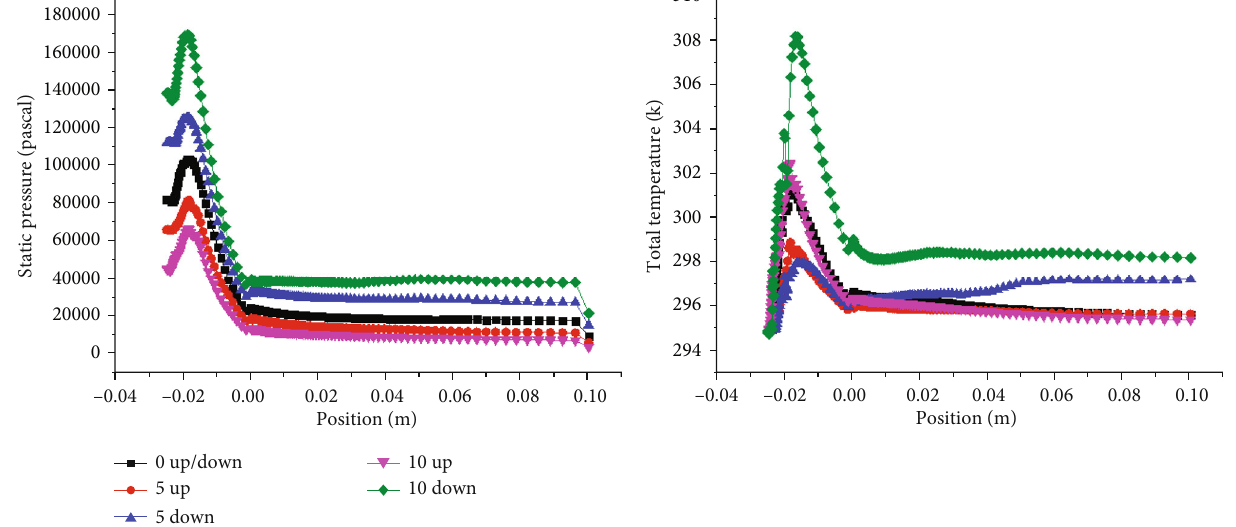
Figure 17: Pressure and temperature distribution of a single recti fi er cone at di ff erent angles of attack.